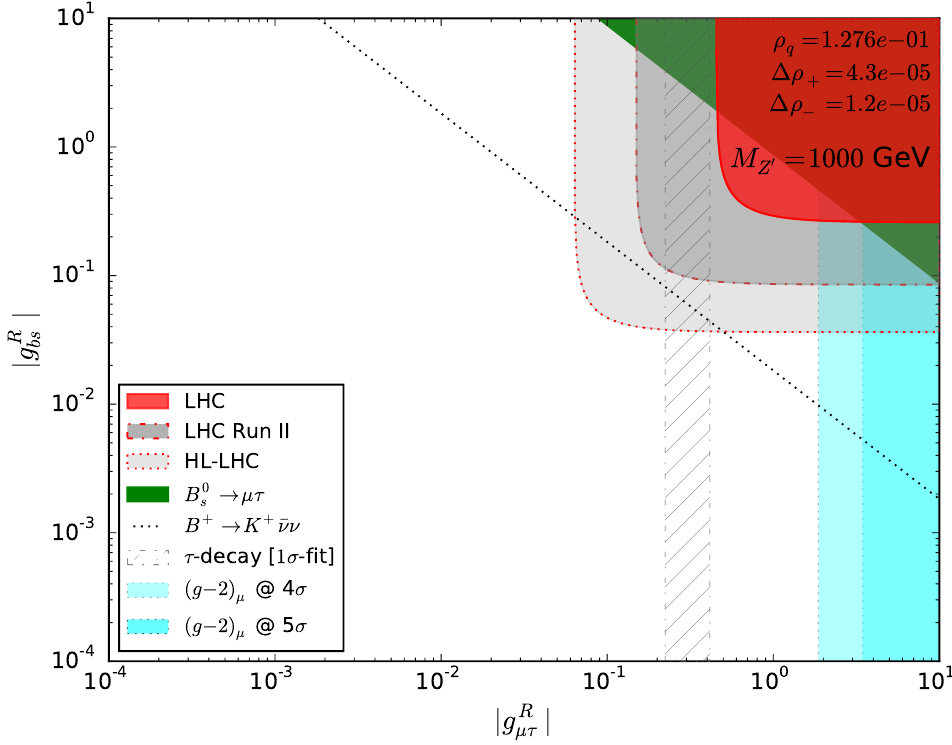
Figure 13 . The (cid:13)avor-violating couplings g R and g R for a Z 0 boson of M Z 0 = 1000 GeV and a (cid:22)(cid:28) bs coupling ratio of (cid:26) q = g L =g R = 0 : 1276. The red area indicates the limit from the ATLAS analysis bs bs p of the process pp ! (cid:22)(cid:28) at s = 8 TeV. The red dash-dotted and dashed lines are projections to the LHC Run II and HL-LHC. The green area represents the excluded region from the decay B 0 ! (cid:22)(cid:28) . s The black dotted line is the limit from B + ! K + (cid:22) (cid:23)(cid:23) applying only for left-handed lepton couplings. The light and dark cyan areas depict the 4 and 5 (cid:27) exclusion bands from (cid:1) a (cid:22) . The black and white hatched area is the preferred 1 (cid:27) region of the observed deviation (cid:1) R = R =R SM (cid:0) 1, also (cid:22)=e (cid:22)=e (cid:22)=e only applicable in the case of purely left-handed